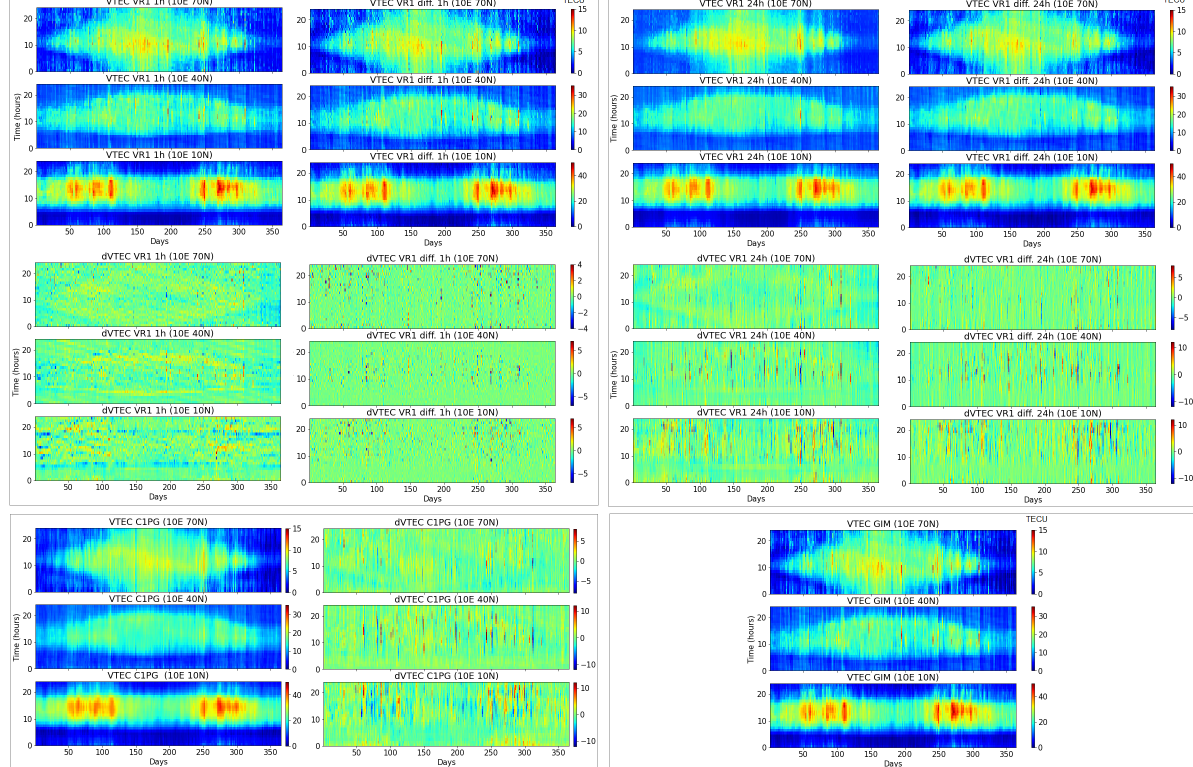
Figure 19. Upper panel left: VR1 model 1 h forecast ( top ) with non-differenced data ( left ) and dif- ferenced data ( right ), corresponding VTEC differences ( dVTEC = VTEC GIM − VTEC VR 1 ) ( bottom ). Upper panel right: VR1 model 24 h forecast ( top ) with non-differenced data ( left ) and differ- enced data ( right ), dVTEC ( bottom ). Bottom panel left: 1 day predicted GIM CODE (C1PG) ( left ), dVTEC = VTEC GIM − VTEC C 1 PG ( right ). Bottom panel right: GIM